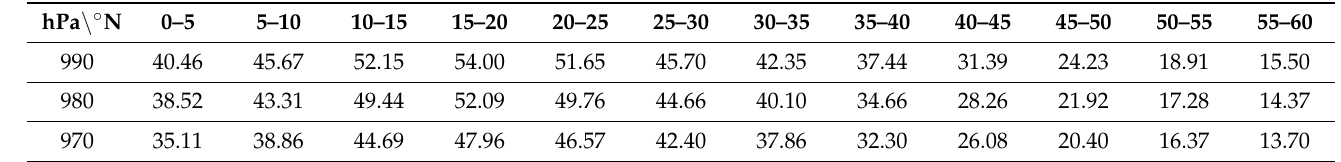
Table A1. Mean error variances (unit: N-unit2) of RO refractivity in each 5 ◦ -latitude interval at 10-hPa-pressure intervals between the equator and 60 ◦ N from 990 to 400